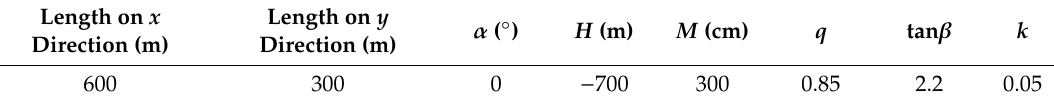
Table 1. PIM parameters and simulated mining area parameters.